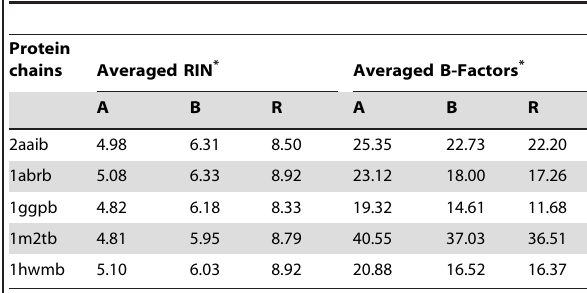
Table 3. The averaged residue interaction numbers and B- Factors. Protein chains Averaged RIN * Averaged B-Factors *